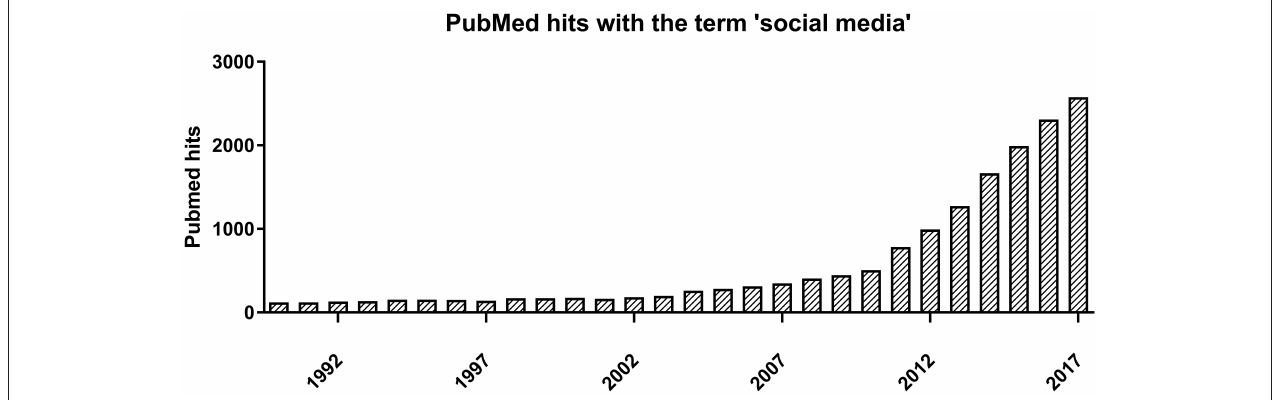
FIGURE 1 | Number of publications found on PubMed with the search term “social media,” as shown by publication